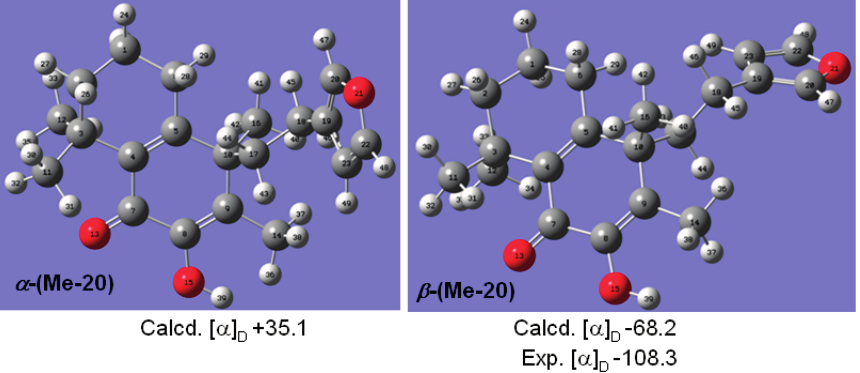
Figure 4. The computational and experimental OR values for α and β -(Me-20) epimers.